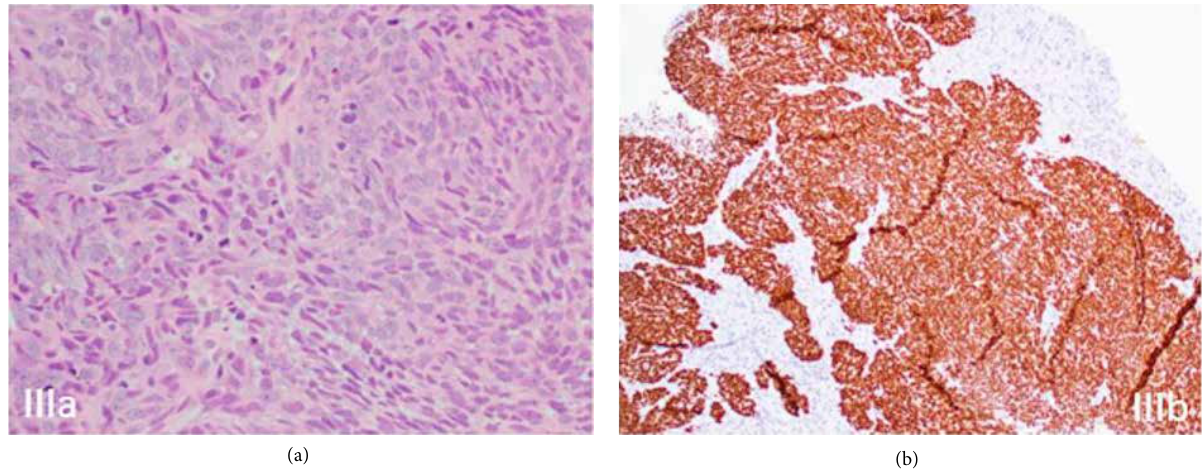
3: (a) Numerous mitotic figures as well as high grade morphology cells with eosinophilic cytoplasm. (b) P40 Positivity proving squamous